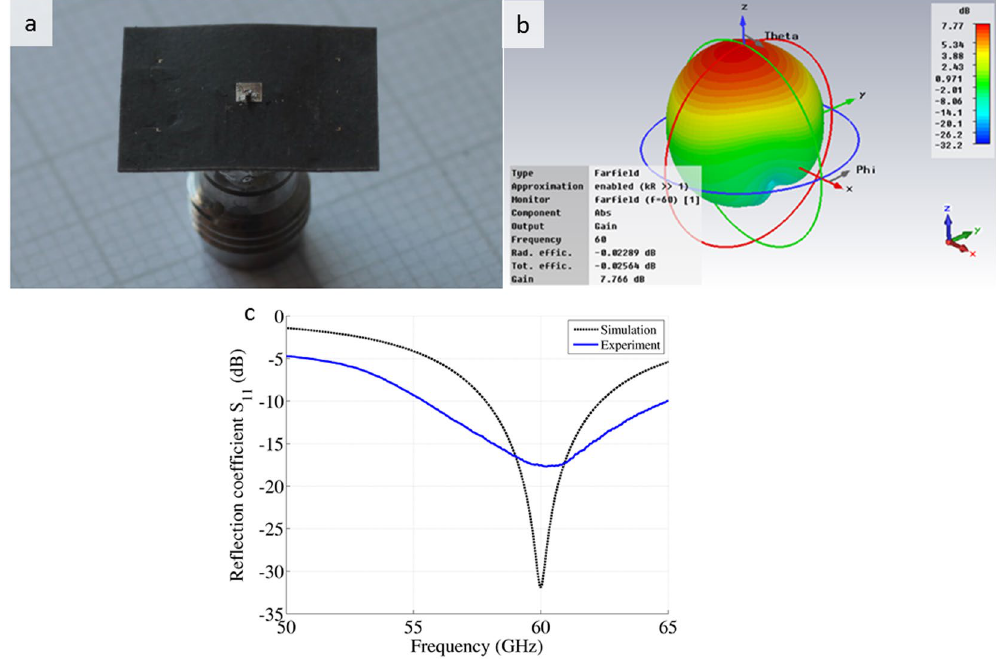
Figure 7. The antenna design, simulation and characterization. ( a ) Photo of the square patch, soldered from the back side. ( b ) Simulated 3D radiation pattern of the antenna gain at 60 GHz, which is the desired operating frequency of the antenna. ( c ) Free space simulated and measured return loss ( S 11 ) for the antenna of Fig. ( a